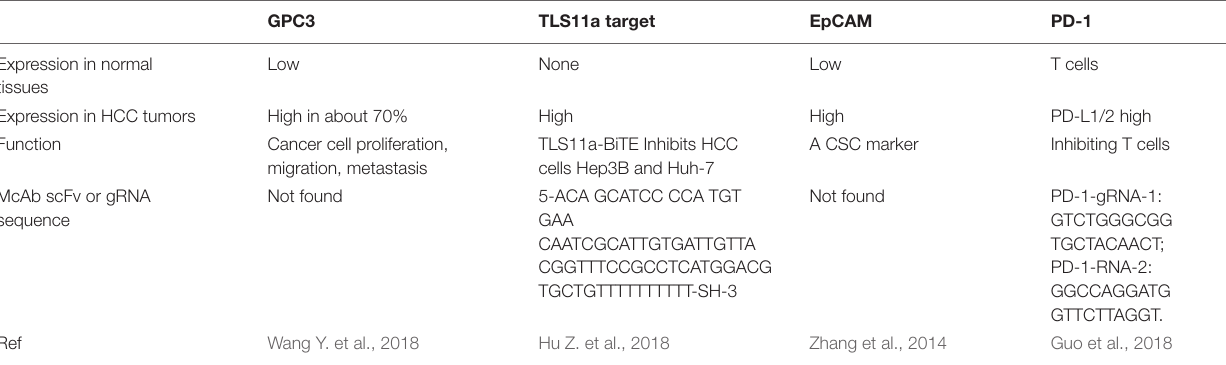
TABLE 1 | Features of the tumor associated antigens of HCC.